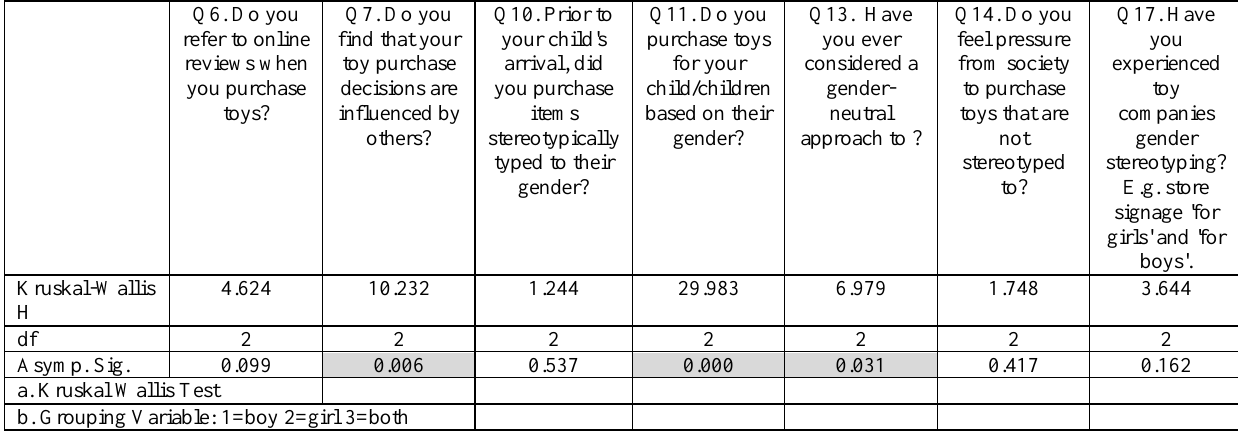
Table 4. Kruskal–Wallis test depending on children’s gender